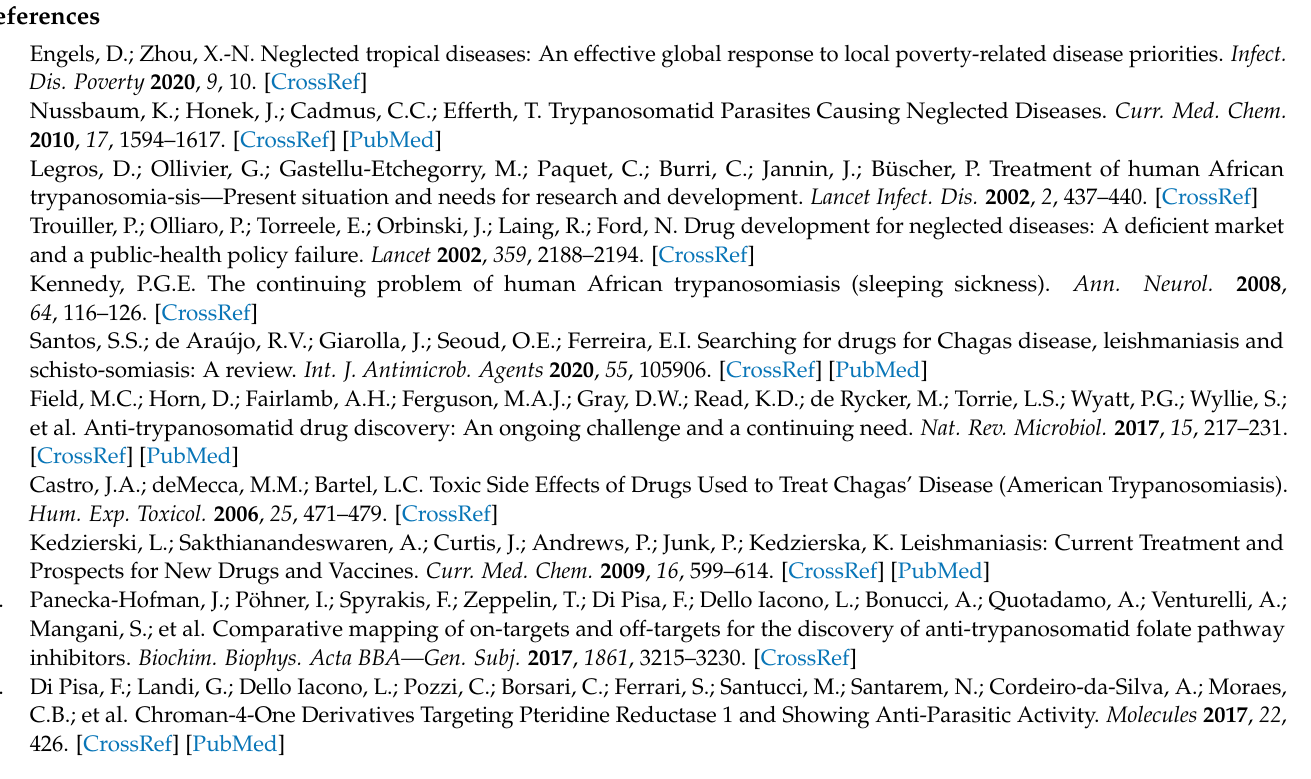
Figure S1: Antifolate- and substrate-like poses in PTR1 and in DHFR. Figure S2: Docking of the most relevant pyrido-pyrimidine, pyrrolo-pyrimidine and pyrimidine derivatives (Table 2) reported in Table 3 (Main Text). Figure S3: Comparison between LmPTR1 and TbPTR1 binding site, and details of the substrate binding loop. Figure S4: Docking pose of other compounds reported in Table 3 (Main Text). Figure S5: Ramachandran plot of the Lm DHFR-TS homology model. Lm DHFR-TS